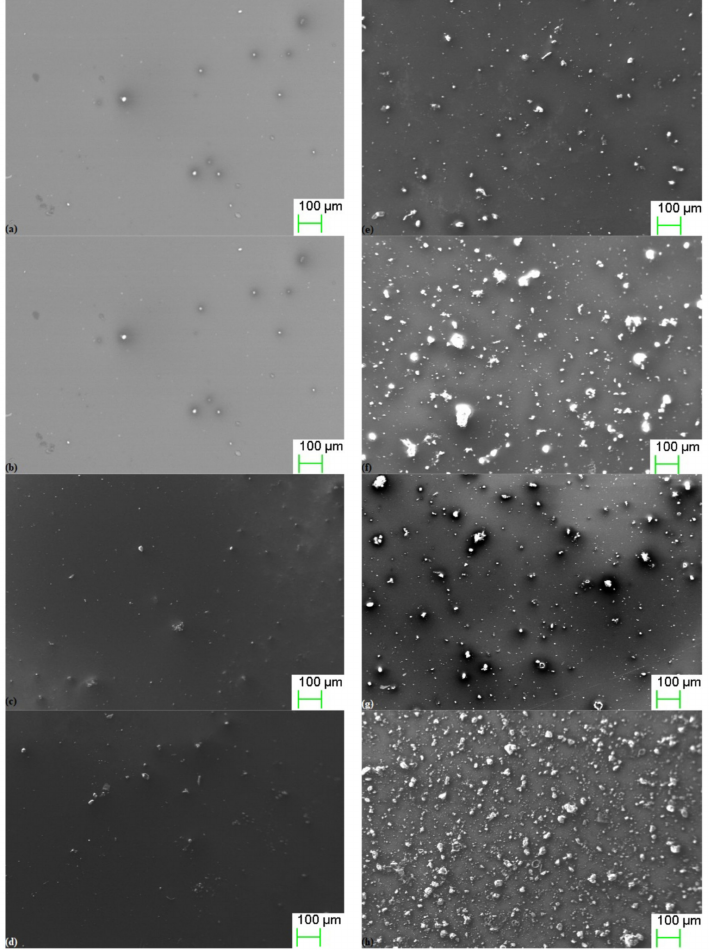
Figure 10. The SEM pictures of the layers deposited by the spray method in the version only with PMMA for the G pigment at a concentration of 1% for the SE ( a ) detector and BDS ( b ) detector, and with the SE detector for the concentration of 2% ( c ), 5% ( d ), 10% ( e ), 15% ( f ), 20% ( g ), and 50% ( h